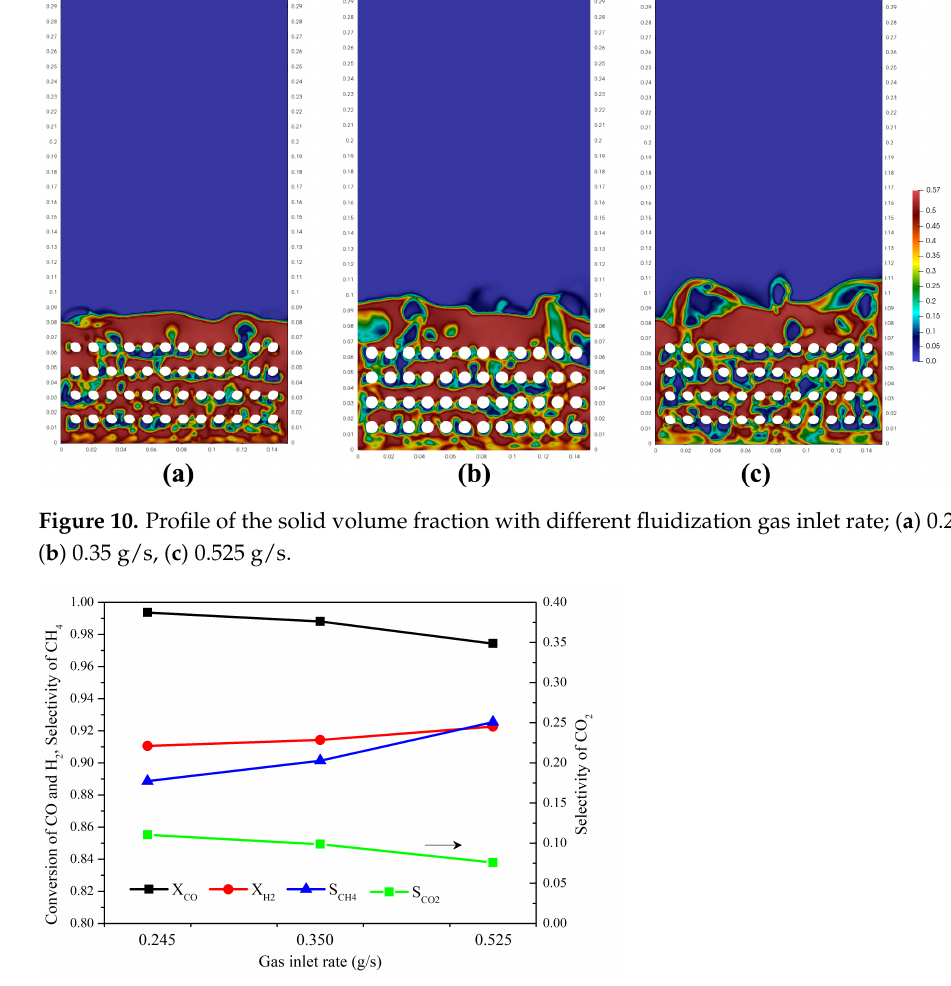
Figure 11. Conversion rate of reactants and selectivity of products with different fluidization gas